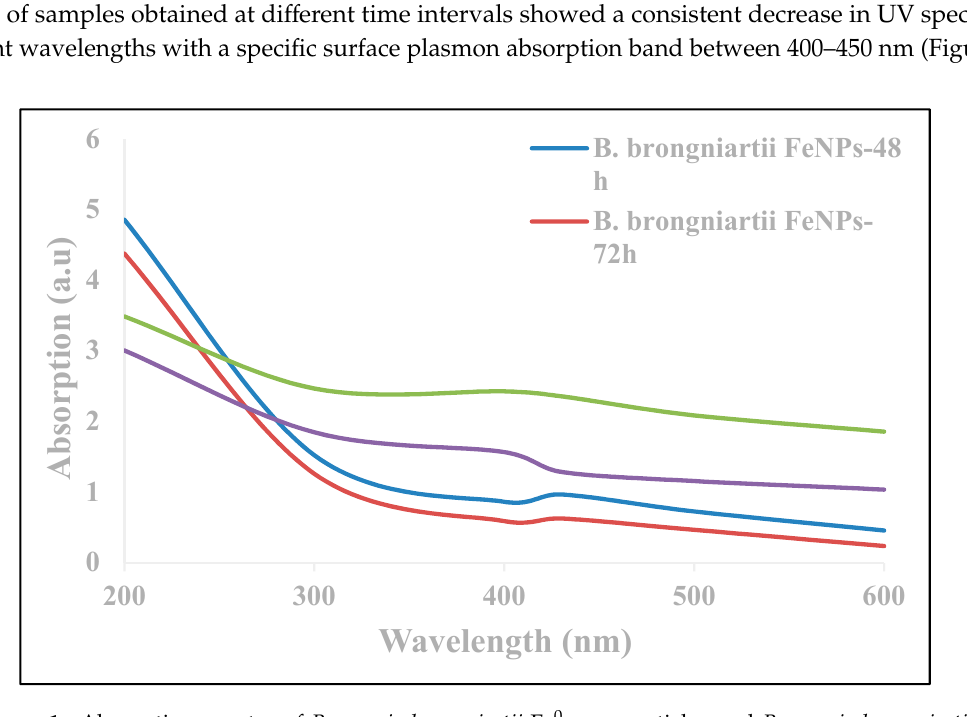
Figure 1. Absorption spectra of Beauveria brongniartii Fe 0 nanoparticles and Beauveria brongniartii conidia at di ff erent wavelengths after 48 and 72 h.